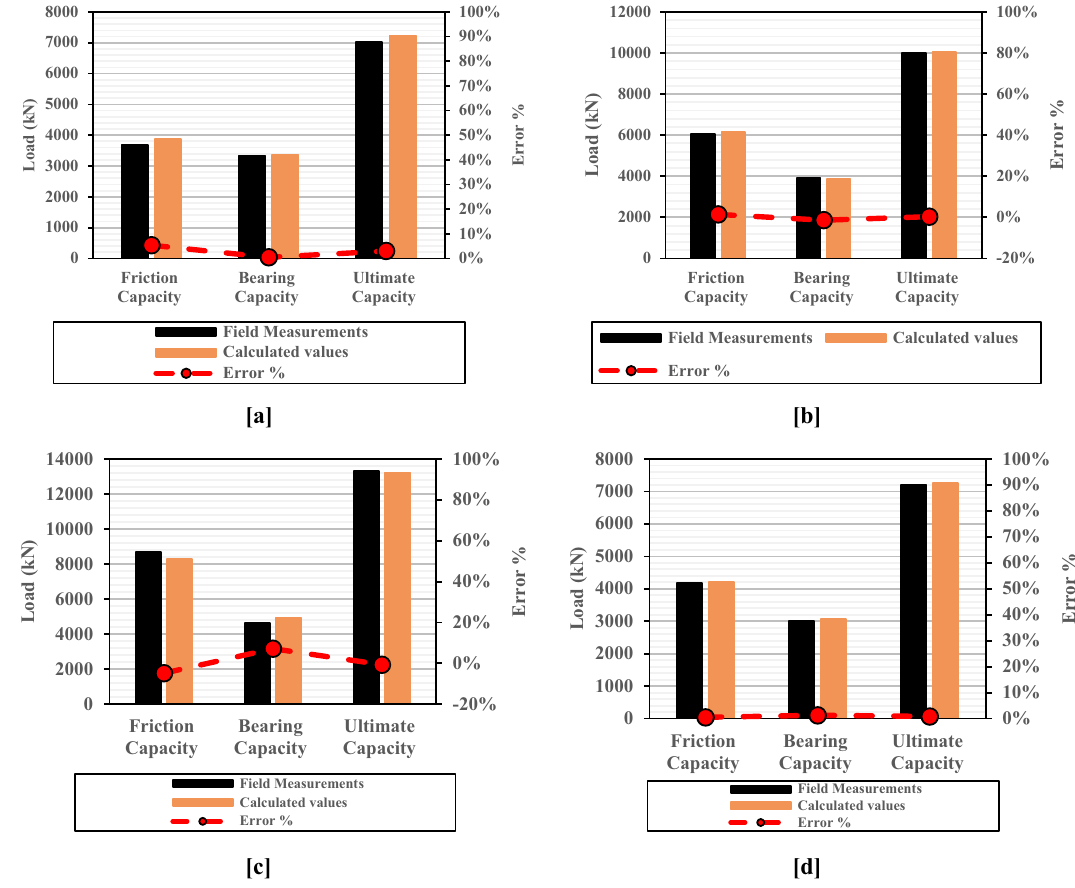
Figure 17. Comparison between field measurements of four insitu LDBP loading tests and the ultimate pile capacity calculated using the Modified Meyerhof method. ( a ) Case (1) for an LDBP (D = 0.7 m) installed in multi-layered soil ( b ) Case (2) for an LDBP (D = 0.8 m) installed in multi-layered soil ( c ) Case (1) for an LDBP (D = 1.0 m) installed in multi-layered soil ( d ) Case (1) for an LDBP (D = 1.2 m) installed in clayey sand